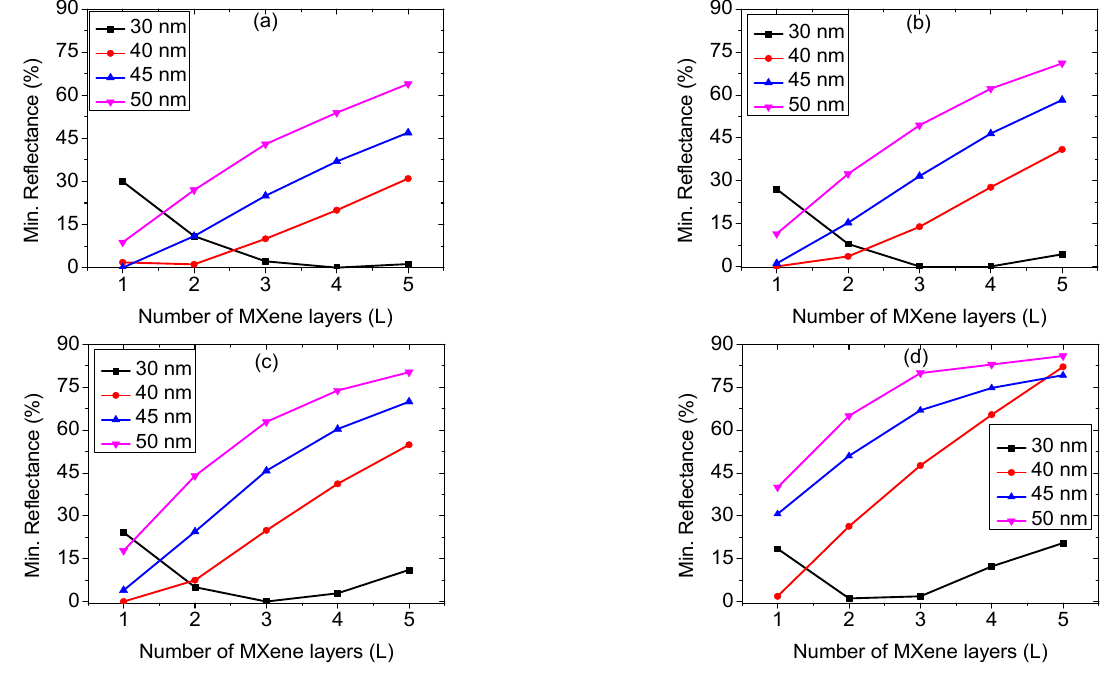
Figure 3. Minimum reflectance variation of the structure with the number of Ti 3 C 2 T x sheets for var-